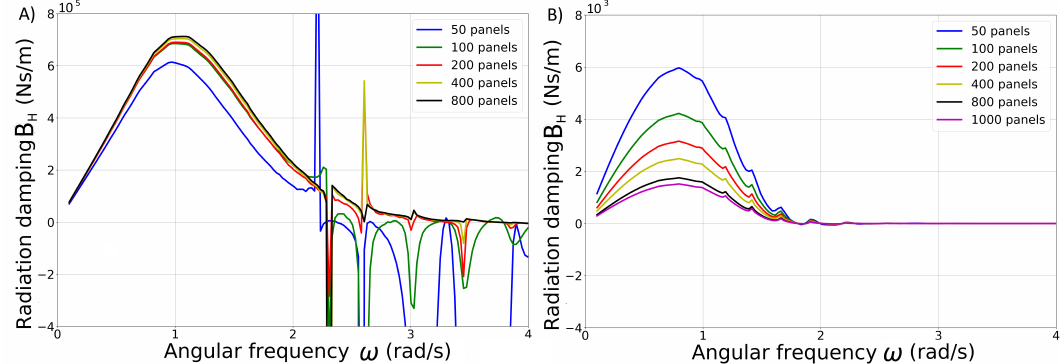
Figure 2. Mesh convergence study for ( A ) the HPA WEC and ( B ) the OSWEC for different panel discretizations.